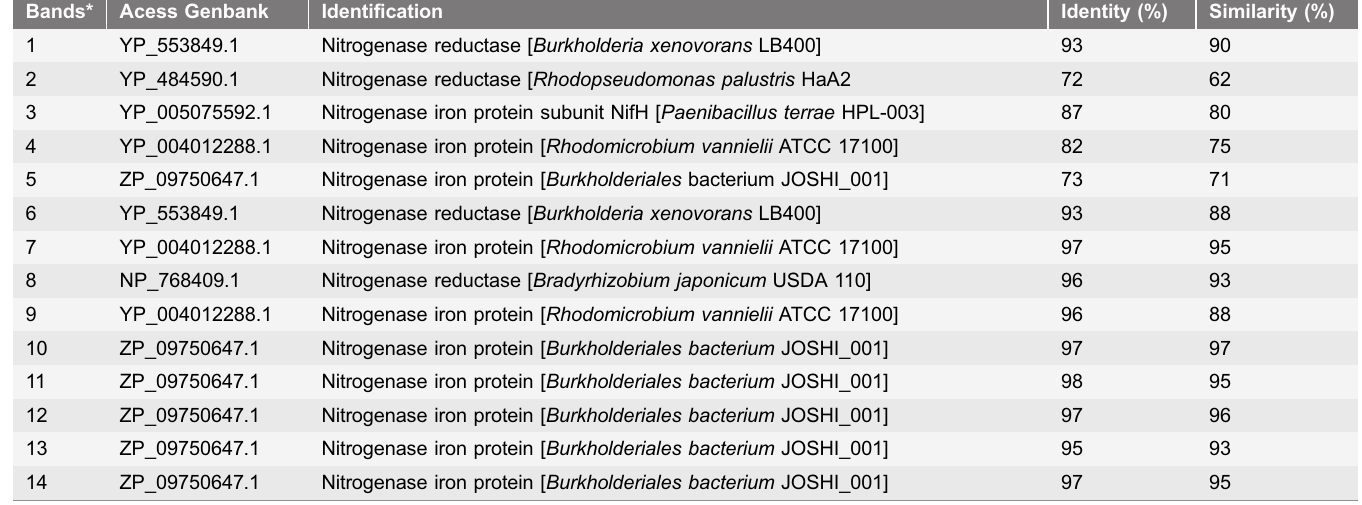
Table 4. Comparison of the nifH gene sequence from Pleurotus ostreatus and sequences of similar genes deposited in